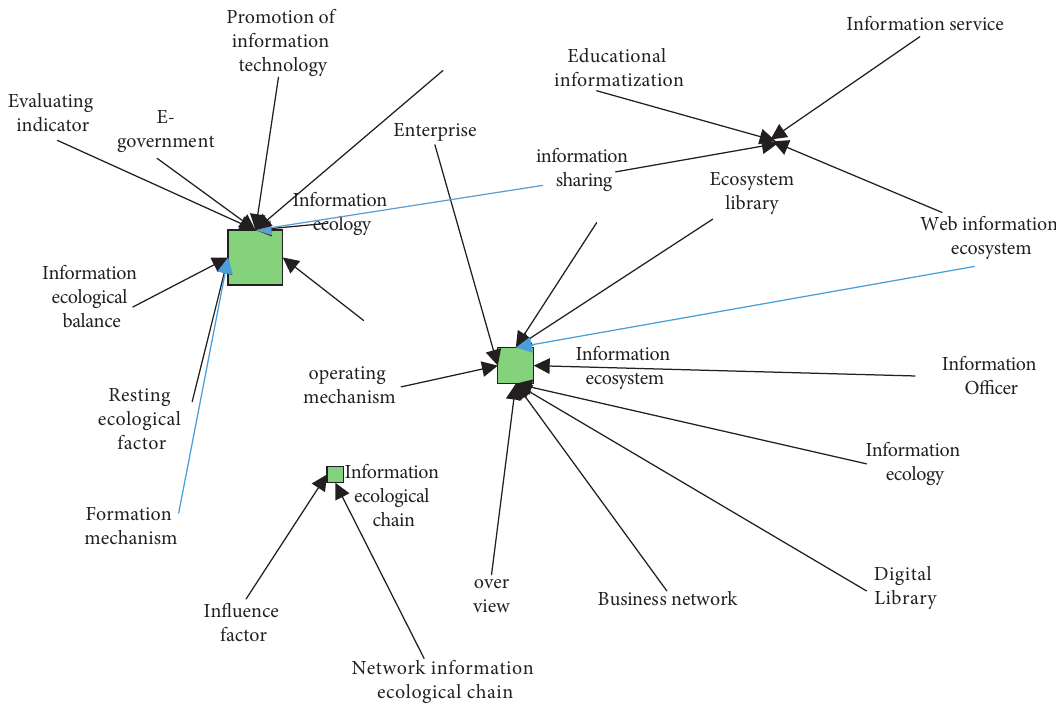
Figure 6: Social network analysis knowledge map.